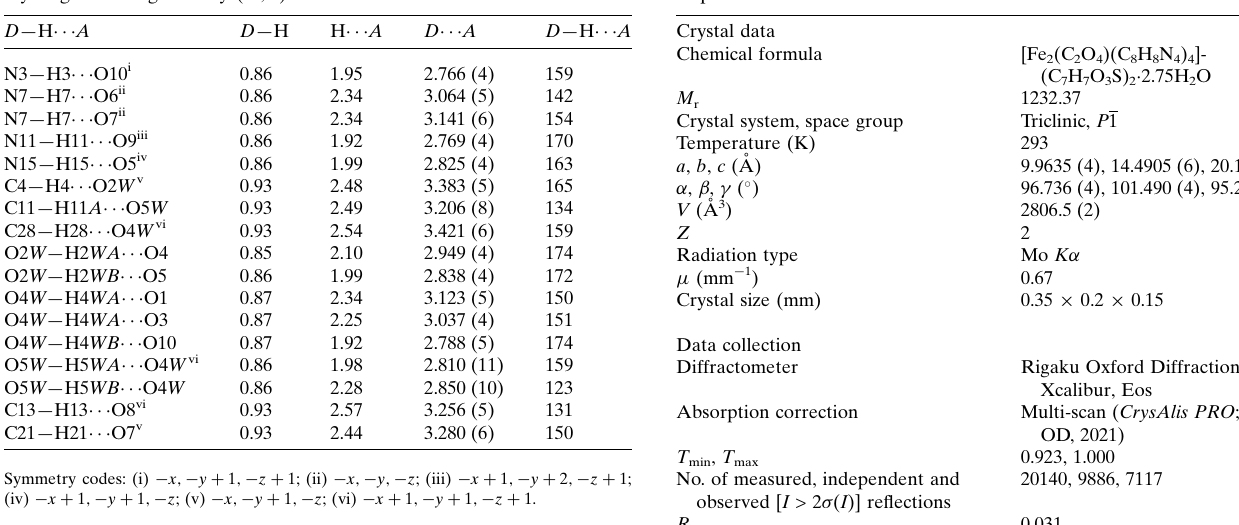
Table 2 Hydrogen-bond geometry (A˚ , (cid:3) ).